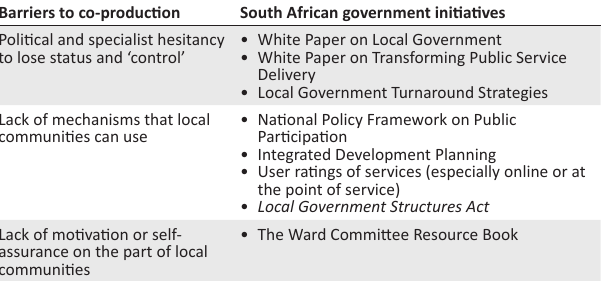
TABLE 1: Barriers to co-production.